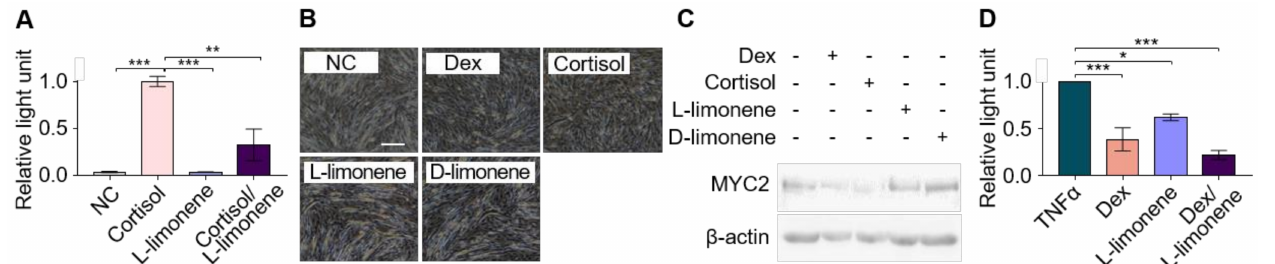
Figure 6. Elucidating the function of L-limonene as a GR-effector. ( A ) GR-mediated transactivation was investigated using a glucocorticoid response element (GRE)-based reporter gene assay, and L-limonene did not show GR-agonist-like activity; ( B ) the muscle atrophy effect was analyzed by monitoring morphologic differences of differentiated C2C12 cells, Dex and Cort inhibited the differentiation of C2C12 cells, whereas L-limonene treated cells differentiated successfully (scale bar = 200 µ m); ( C ) the expression level of the myosin heavy chain II (MYC2) was measured using Western blotting, the expression of MYC2 was inhibited in Dex and Cort-treated cells, whereas L-limonene did not suppress MYC2 expression; ( D ) the reporter gene assay was performed to monitor the GR-mediated tethered indirect transrepression effect of L-Limonene (* p < 0.05, ** p < 0.01 and *** p <